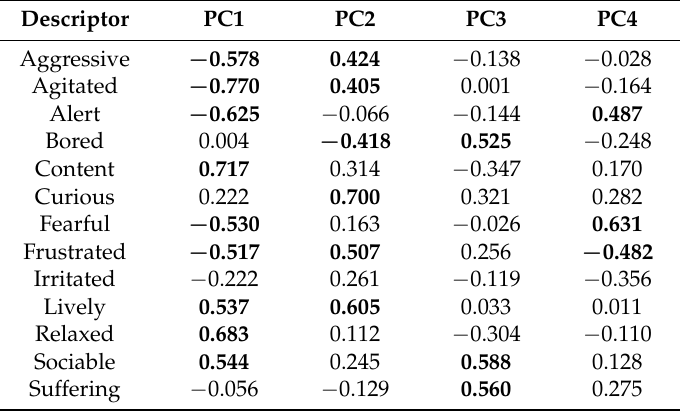
Table 5. Loadings for Qualitative Behaviour Assessment descriptors on the first four PCs. The highest loadings for each factor are